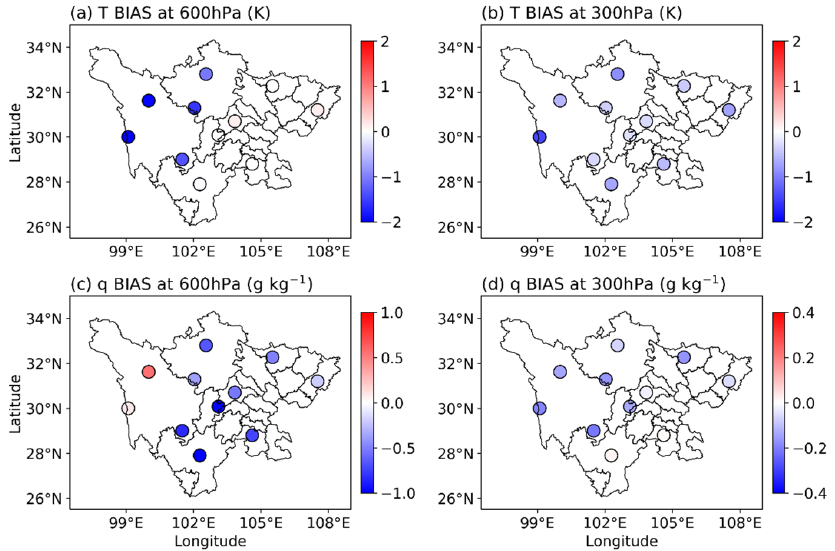
Figure 4. Spatial distribution of bias of T at 600 hPa ( a ) and 300 hPa ( b ), and bias of q at 600 hPa ( c ) and 300 hPa ( d ), for different radiosonde sites for AIRS/AMSU (AA) data.